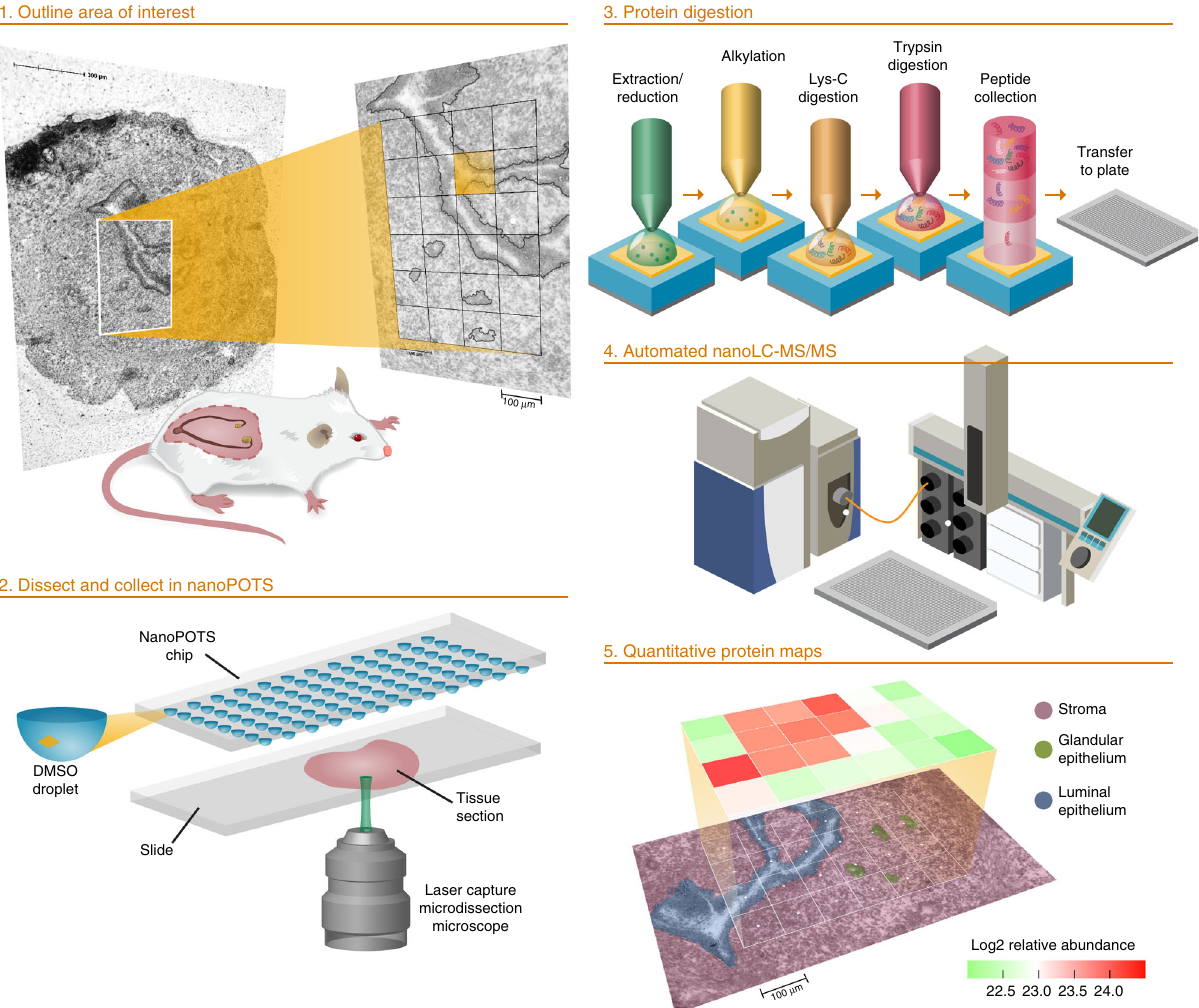
Fig. 1 Schematic work fl ow for high-throughput, spatially resolved proteomics using the nanoPOTS imaging platform. The authors thank PNNL Graphic Designer Nathan Johnson for preparing the fi